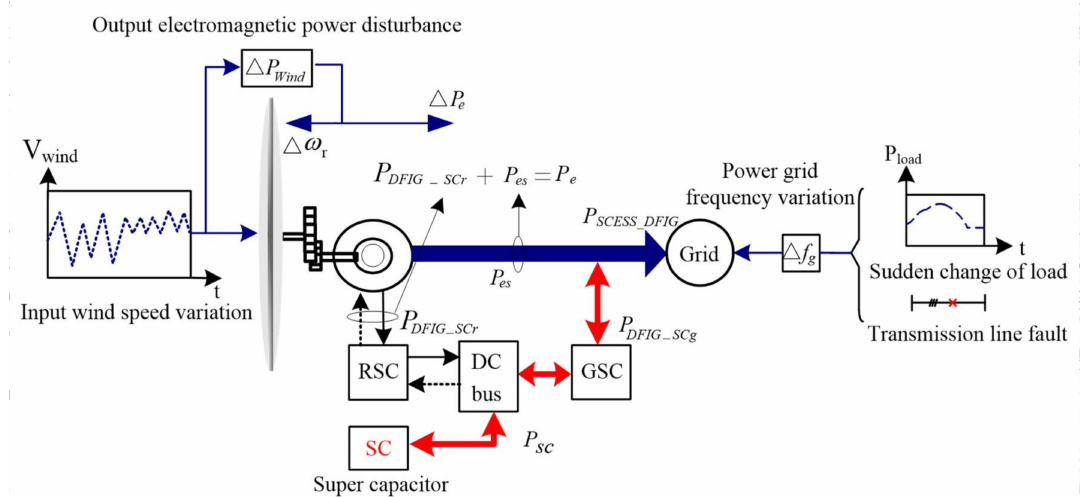
Figure 1. The topology of a doubly fed induction generator system with rotor-side supercapacitor energy storage system (SCESS-DFIG) grid with external power disturbances. RSC: rotor-side converter; SC: super capacitor; GSC: grid-side